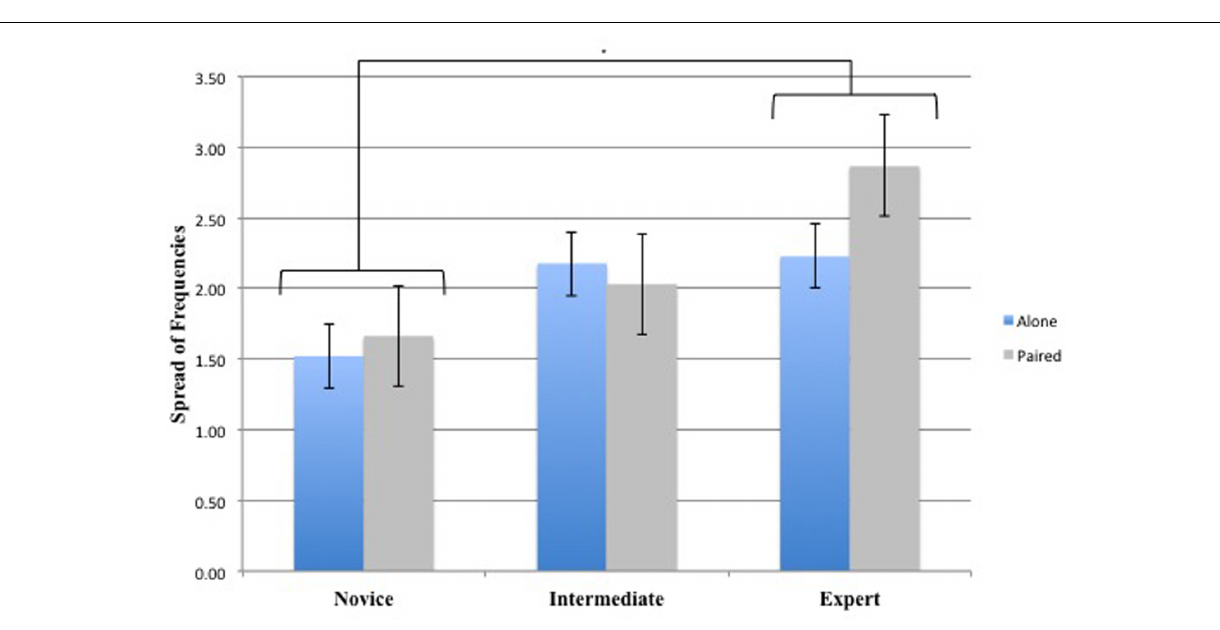
everyone could perform but that only experts actually